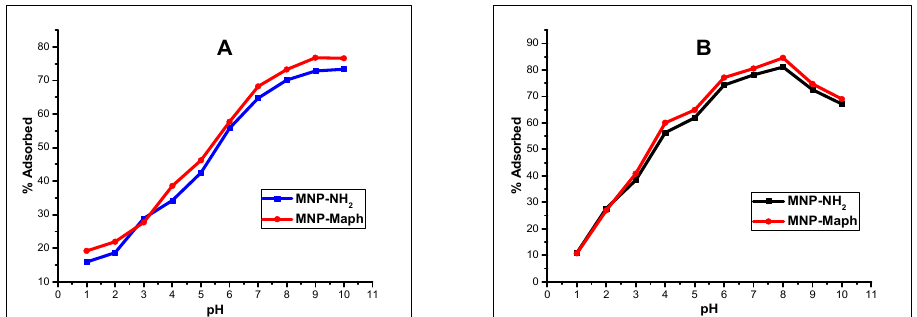
Figure 2. Effect of pH on the adsorption of ( A ) Zn(II) and ( B ) As(III) from aqueous solution by Magnetic Nanoparticle (MNP)-Maph. (conditions: 24 h contact time, adsorbent dose: 40 mg, temperature: 20 °C, adsorbate concentration: 100 mg L − 1 , adsorbate amount: 20 mL and 200 rpm agitation speed).